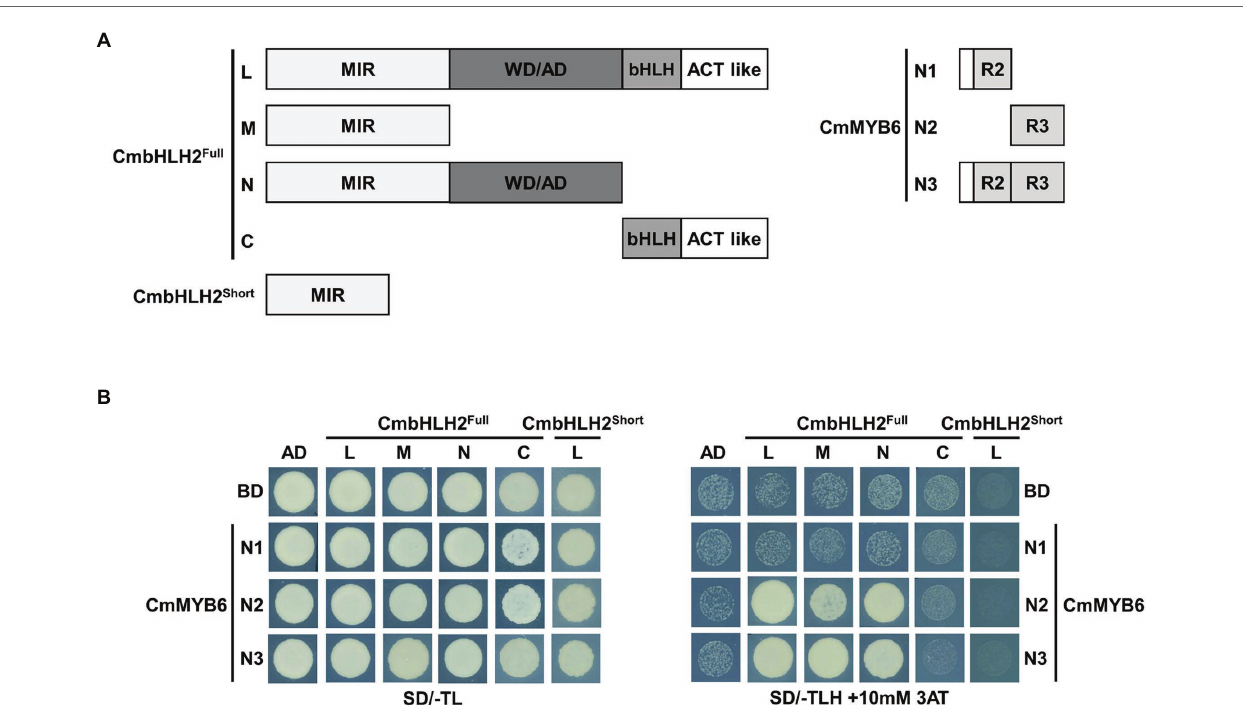
FIGURE 6 | Physical interactions among CmbHLH2 Full , CmbHLH2 Short , and CmMYB6. (A) Diagram of the constructs used in the Y2H experiment. The amino acid positions of the fragments are numbered. (B) Protein–protein interactions among CmbHLH2 Full , CmbHLH2 Short , and CmMYB6, as revealed by Y2H analysis. SD/ - TL, minimal medium lacking Trp and Leu; SD/ - TLH + 3AT, minimal medium lacking Trp, Leu, and His but containing 10-mM 3-amino-1,2,4-triazole (AT). AD and BD indicate the activation domain and binding domain,